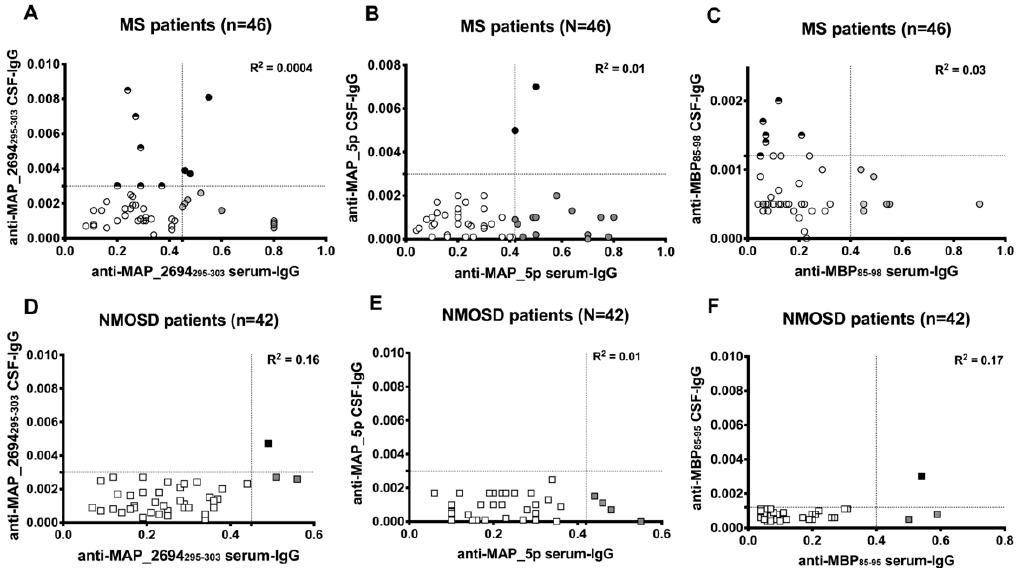
Figure 3. Correlations between CSF and serum anti-MAP_2694 295–303 , anti-MAP_5p, and anti-MBP 85–95 antibody titers from the patients with multiple sclerosis ( A – C ) and NMOSD ( D – F ). Each circle represents the titer for one patient. Dotted lines indicate the cut-off for positivity used in each assay, as calculated by ROC analysis.